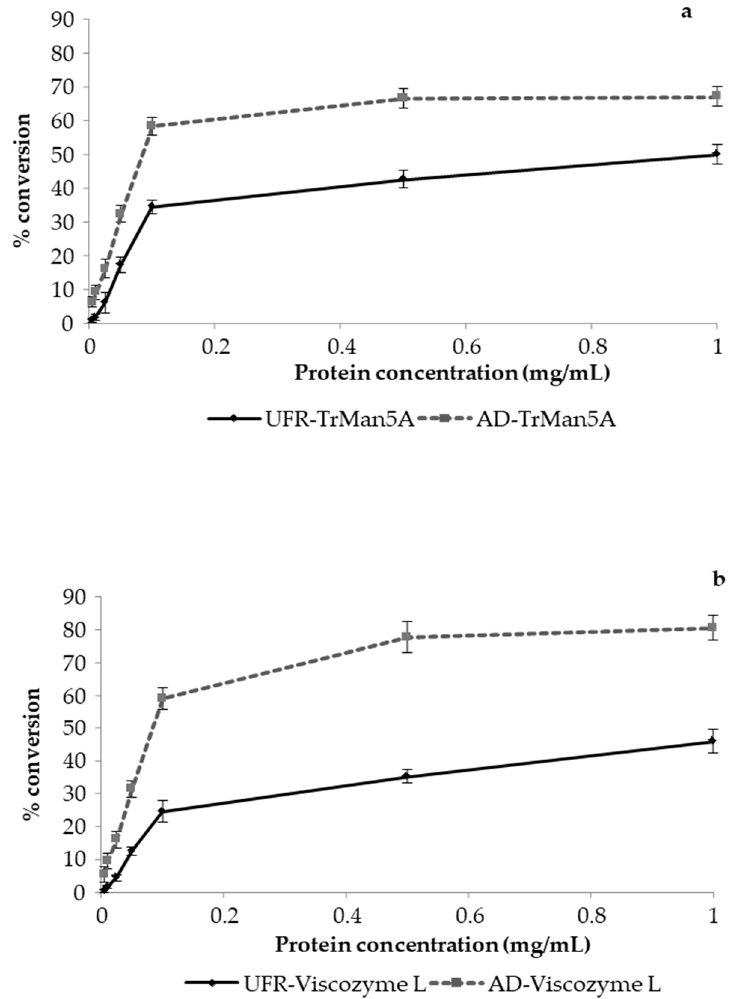
Figure 5. Hydrolysis of UFR and AD preparations using different concentrations of ( a ) Tr Man5A ( b ) Viscozyme L. Tr Man5A or Viscozyme L were used at seven different concentrations (0.005, 0.01, 0.025, 0.05, 0.1, 0.5 and 1.0 mg/mL) for hydrolysis of the SSL-AcGGM preparations UFR and AD. The substrates were used at an initial concentration of 100 mg/mL of GGM and the enzymatic hydrolysis was carried out over 24 h of incubation at 40 ◦ C and pH 5.0. The reducing sugar equivalents were determined using the DNS method and the % conversion was calculated using a mannose standard curve.